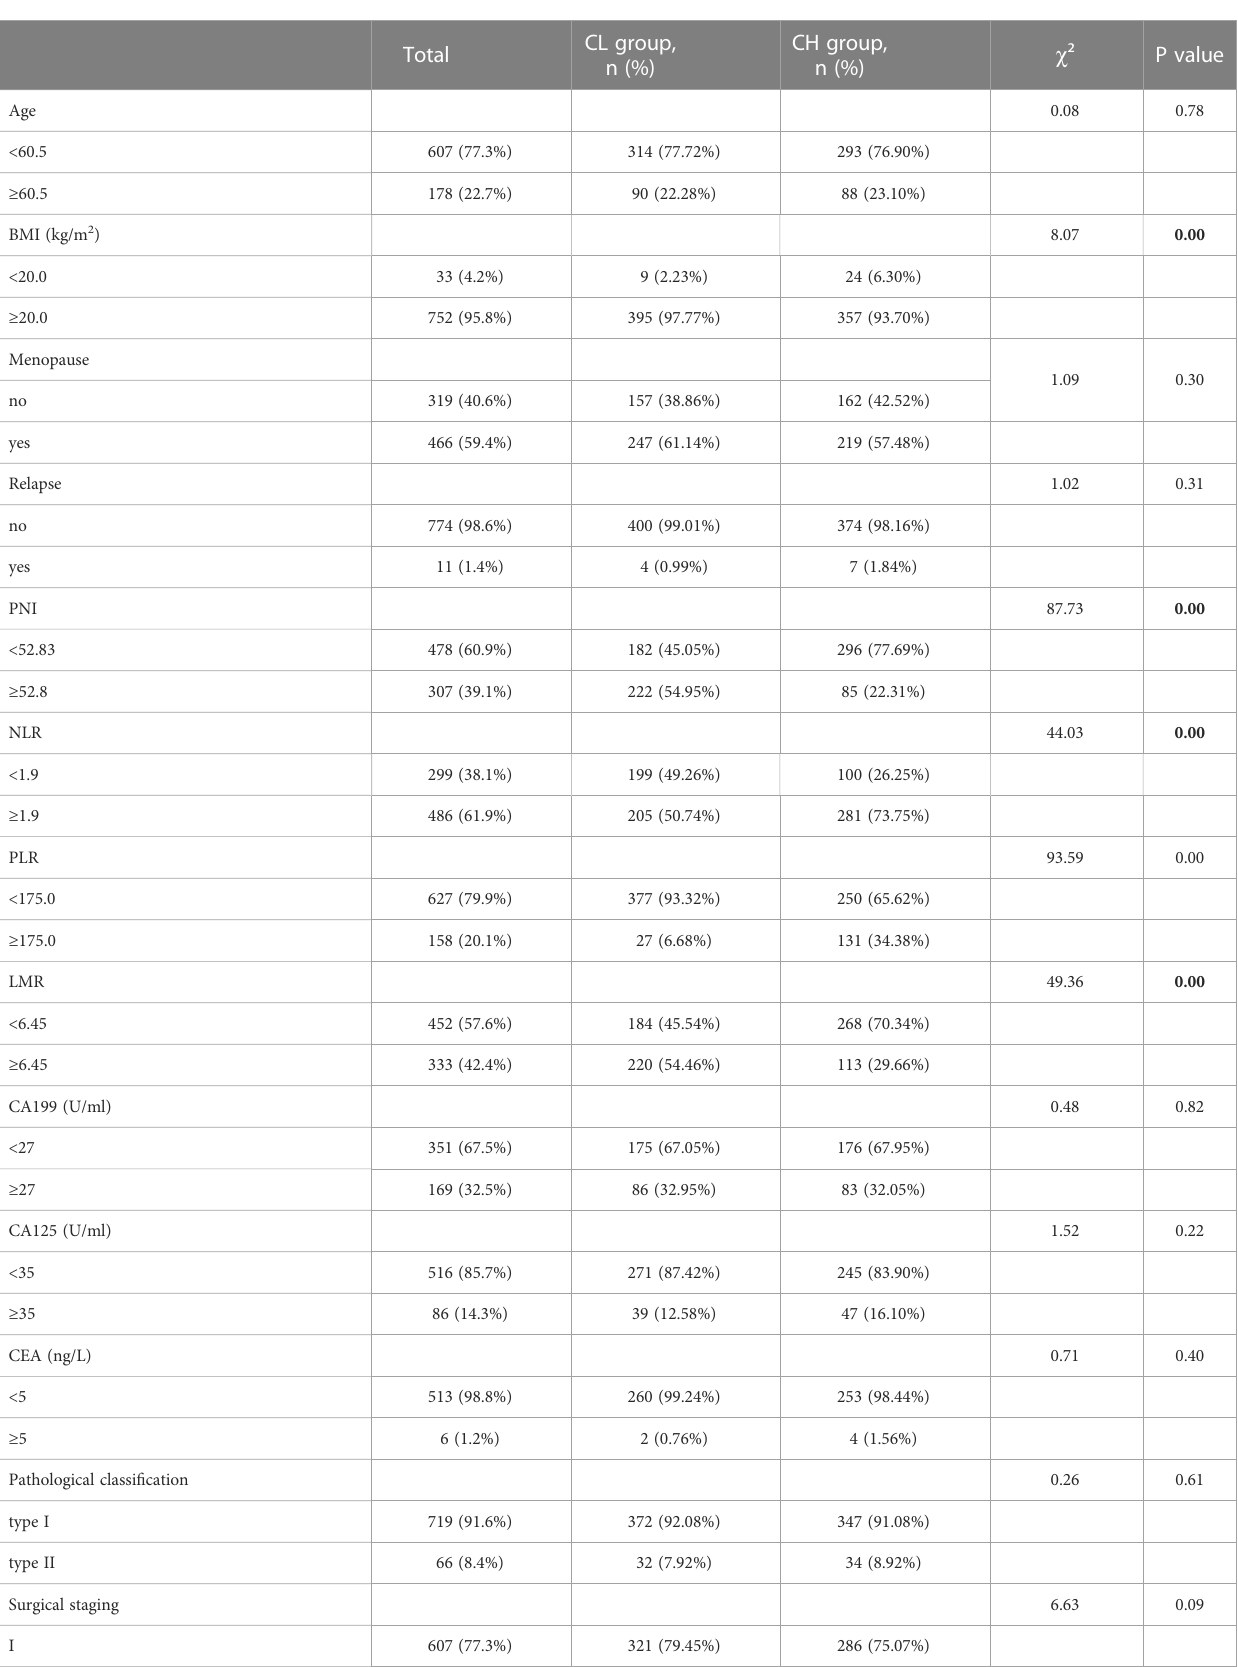
TABLE 3 CONUT scores and some clinicopathological factors are